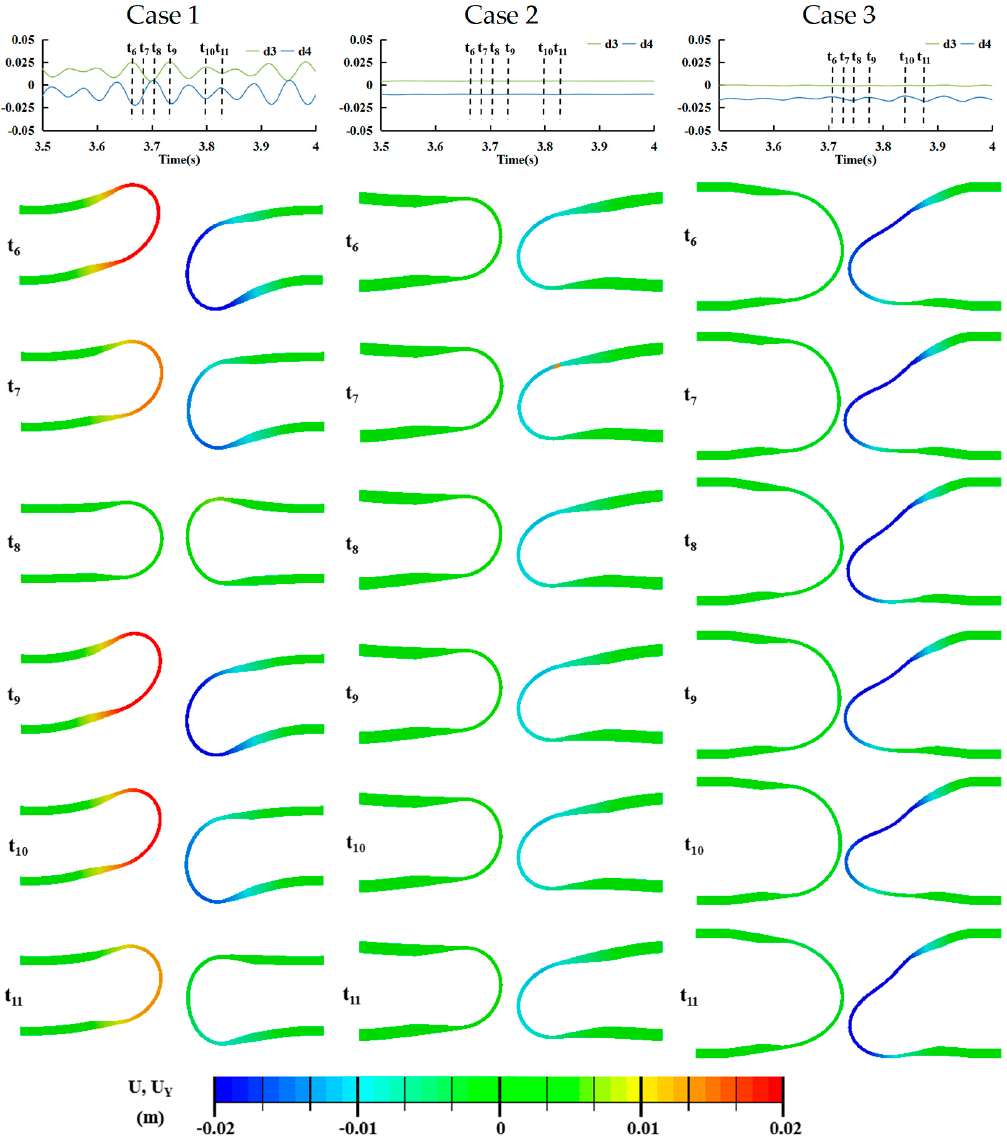
Figure 18. Comparison of typical deformation forms for the three schemes in the stable vibration stage.